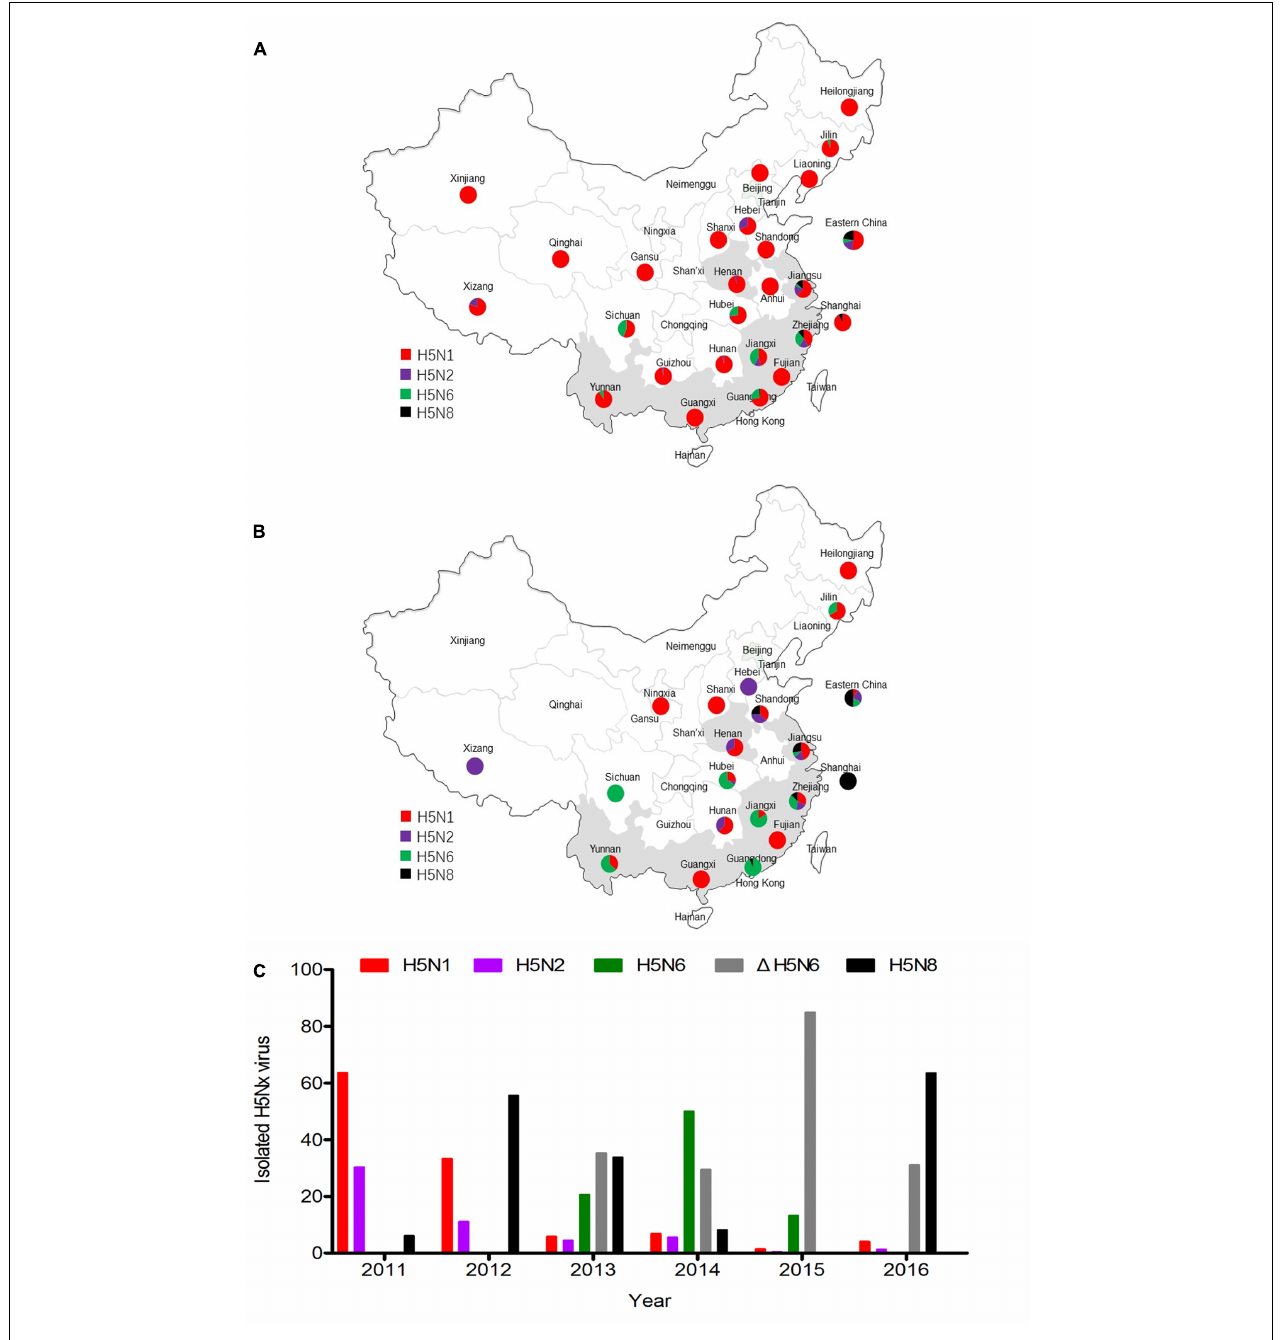
FIGURE 1 | Epidemiology and distribution of H5Nx avian influenza viruses in China. (A) Distribution of H5Nx AIVs in China 1996–2010. (B) Distribution of H5Nx AIVs in China 2011–2016. (C) The isolation rate of H5Nx viruses isolated in China. Data are from NCBI (https://www.ncbi.nlm.nih.gov/genome/viruses/variation/flu/) and GISAID (http://platform.gisaid.org/epi3/frontend). Colors depict different virus subtypes. H5N1, H5N2, H5N6, (cid:49) rH5N6, and H5N8 are shown in red, purple, green, gray, and black, respectively.